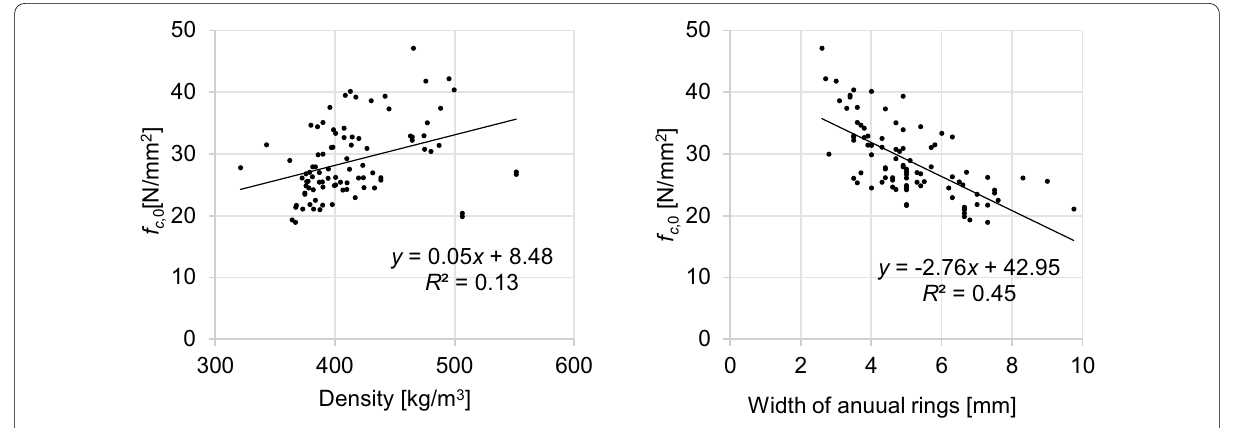
Fig. 8 f c, 0 against density and width of annual